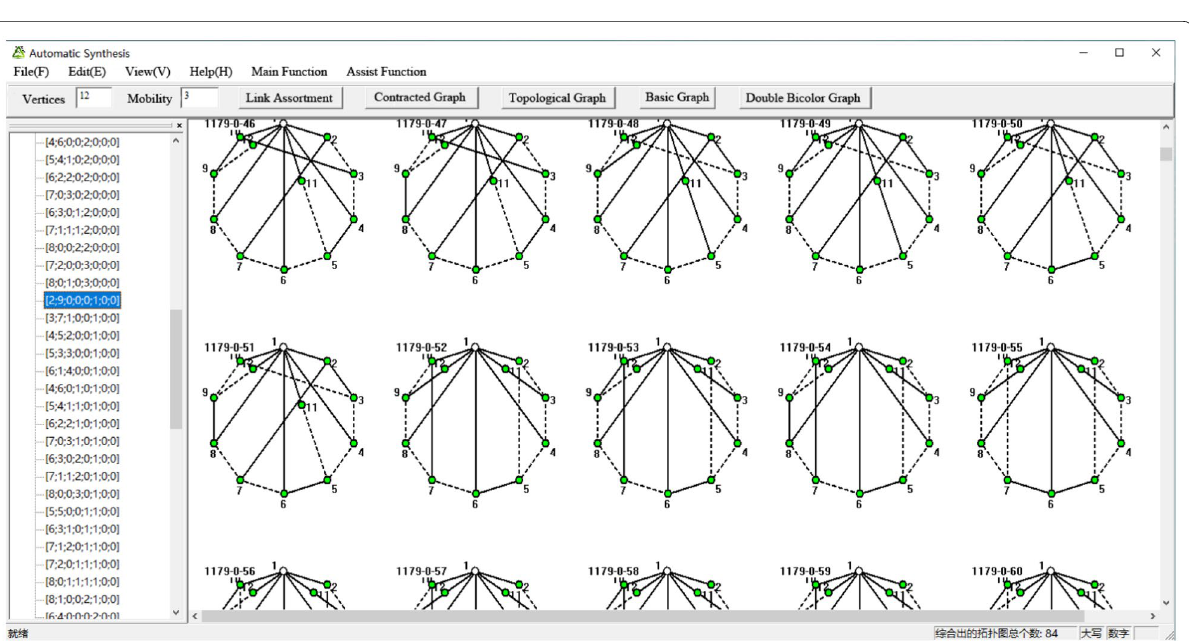
Figure 5 Obtained DBGs for 11-link 2-DOF EGTs with 7 coaxial